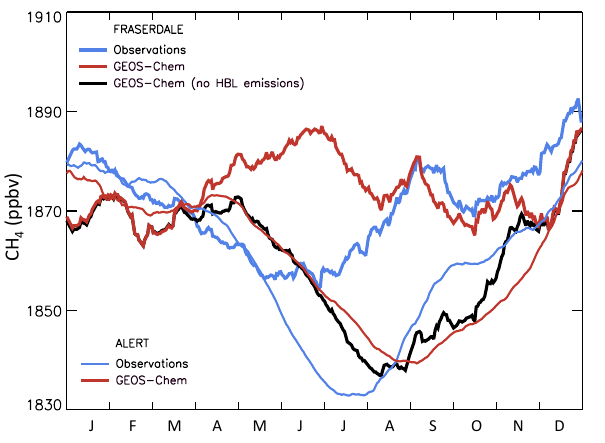
Fig. 4. Mean seasonal differences in CH 4 concentration between Fraserdale and Alert ( 1 CH 4 ) for 2004–2008 (data in Fig. 3). Ob- servations (blue) are compared to the standard GEOS-Chem sim- ulation, a sensitivity simulation restricting emissions to snow-free ground, and a sensitivity simulation with no HBL